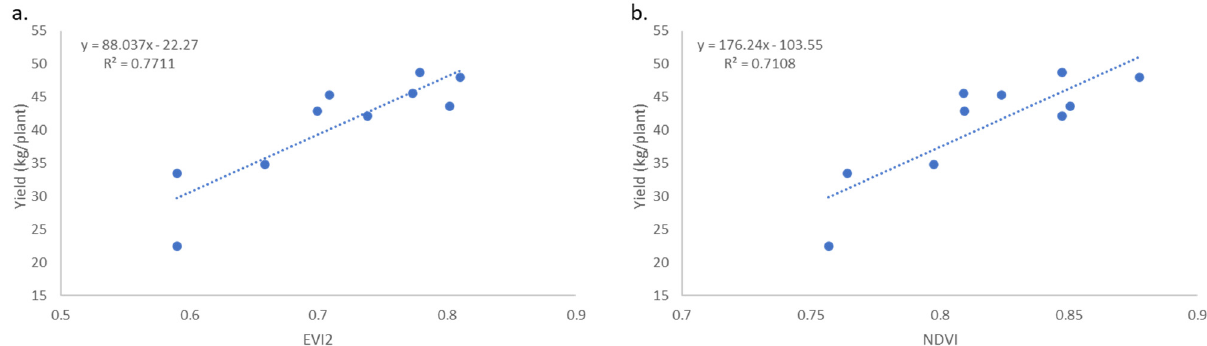
Figure 10. Scatterplot and linear regression of banana plant yield related to ( a ) the Enhanced Vegetation Index 2 (EVI2) and ( b ) the Normalised Difference Vegetation Index (NDVI) derived from UAV data captured closest to the flower emergence dates.